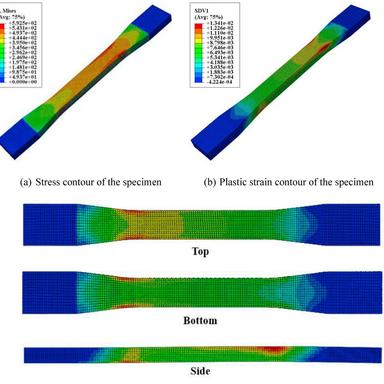
Stress and plastic strain contour for the tensile simulation.